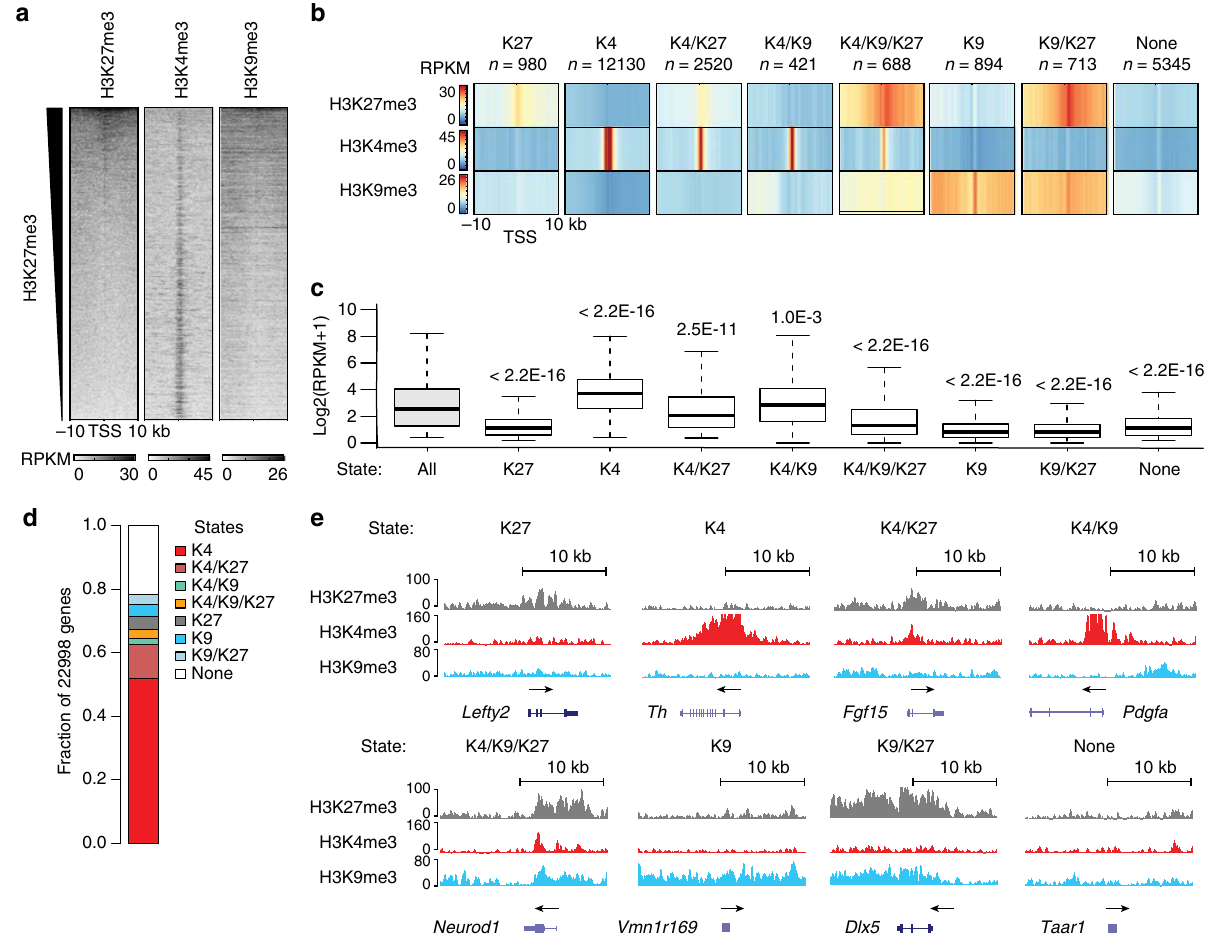
Fig. 2 Histone modi fi cations and gene expression in adult mDA neurons. a H3K27me3 and H3K9me3 abundance around TSS is inversely correlated with H3K4me3 abundance: Heatmaps showing genome-wide abundance of H3K27me3, H3K4me3, and H3K9me3± 10 kb around TSS of individual genes in mDA neurons as RPKMs obtained by ChIP-seq. Heatmaps were sorted for descending H3K27me3 abundance. b Categorization of TSS regions into chromatin states: Heatmap pro fi les of average H3K27me3, H3K4me3, and H3K9me3 RPKMs ± 10 kb around TSS of genes per de fi ned chromatin state in mDA neurons (denoted as K27, K4, K4/K27, K4/K9, K4/K9/K27, K9, K9/K27, and None, respectively). c Individual chromatin states are associated with different levels of gene expression: box-plots showing the expression levels (log2(RPKM + 1)) of genes in the different chromatin-state categories. The center line is the median, bounds are the 25th and 75th percentiles, and whiskers are ±1.5 IQR. Chromatin states with an average gene expression that is different compared to the global average gene expression are indicated by p -values obtained by a two-sided Wilcoxon rank-sum test. d Genome-wide relative abundance of ChIP-seq de fi ned chromatin states in promoter regions ±10 kb around TSS in mDA neurons. e UCSC Genome browser excerpts (https://genome.ucsc.edu) showing examples of enrichment for H3K27me3 (gray, vertical scale 0 – 100 RPKM), H3K4me3 (red, vertical scale 0 – 160 RPKM), and H3K9me3 (blue, vertical scale 0 – 80 RPKM) at representative genes per chromatin state in mDA neurons. Each plot spans 20